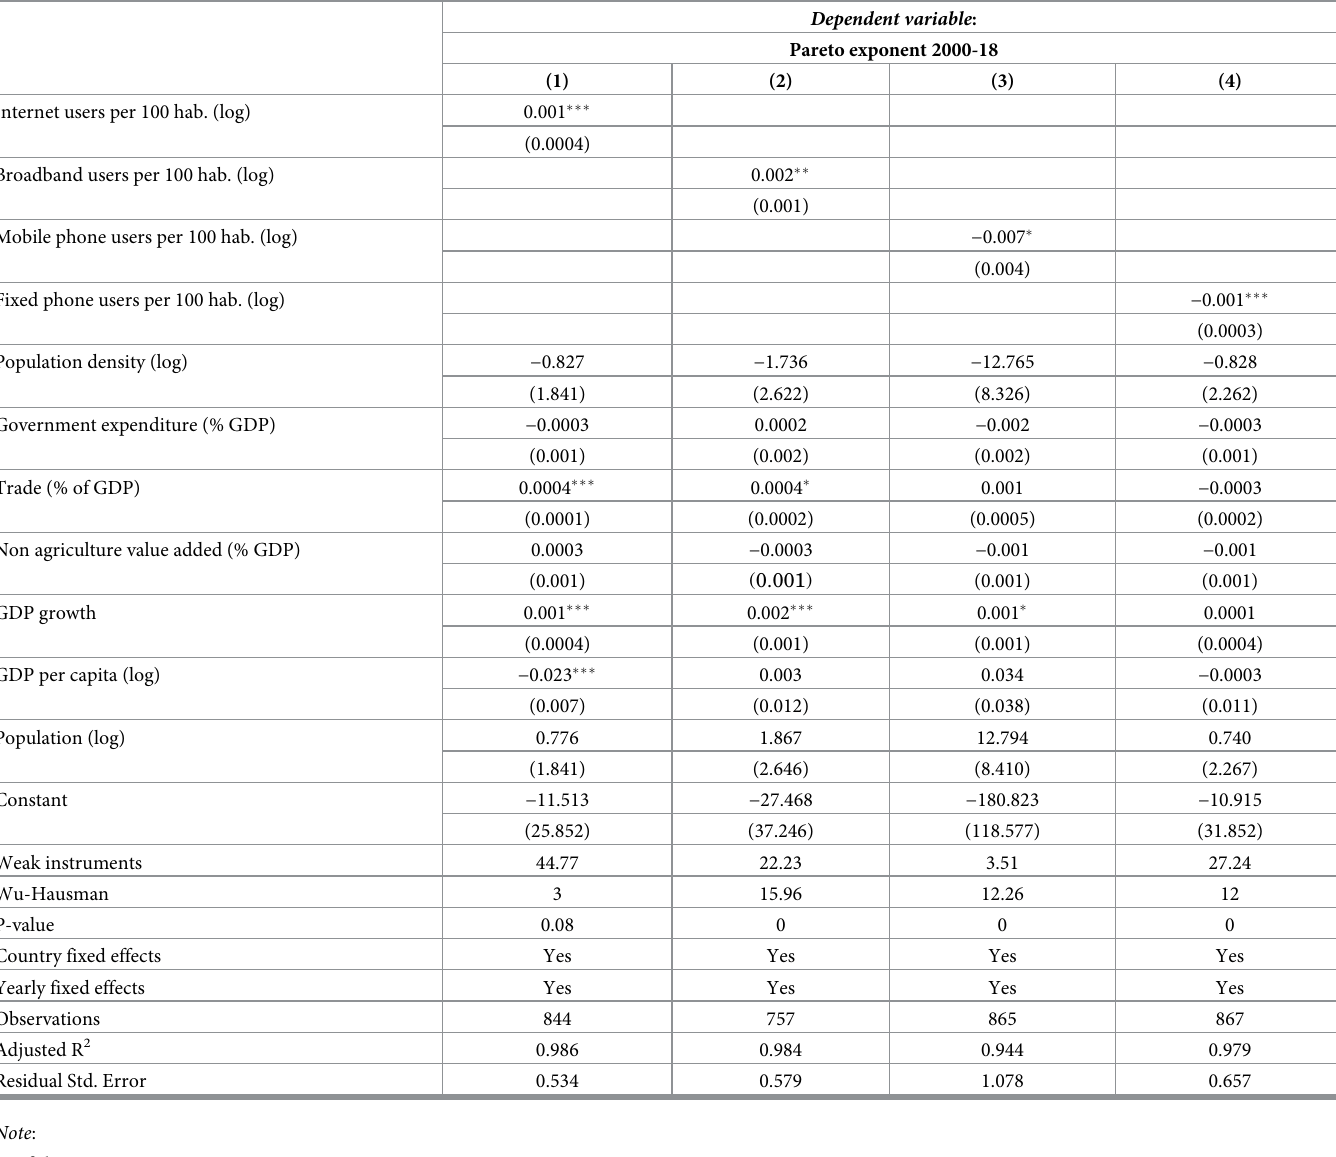
Table 5. 2SLS estimation of Eq